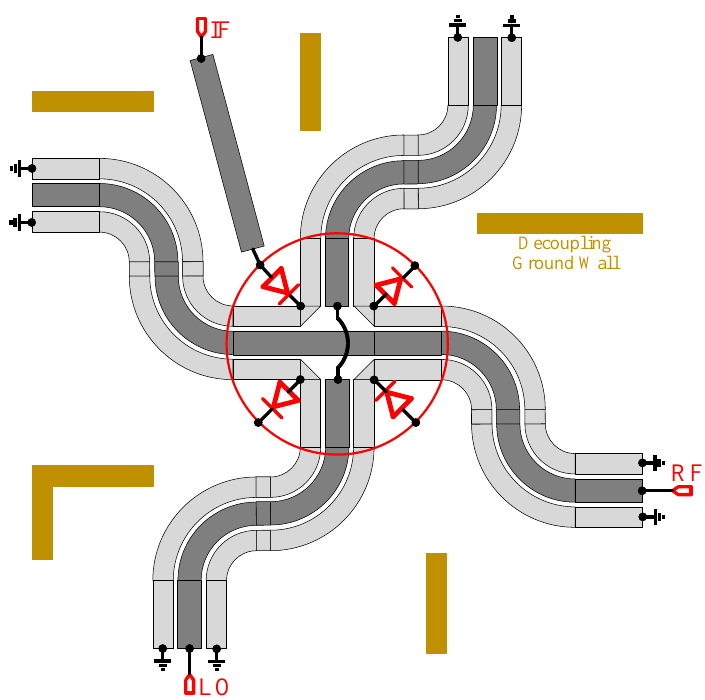
Figure 6. Schematic of the modified star mixer.